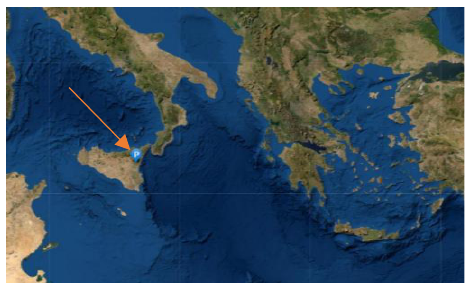
Figure 2. Onshore dataset point of reference (37.60°,15.00°). The arrow indicates the considered location.